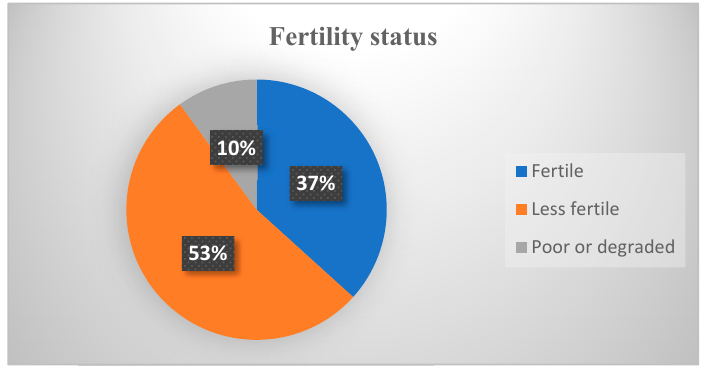
Figure 1. Perceived fertility status of soil.